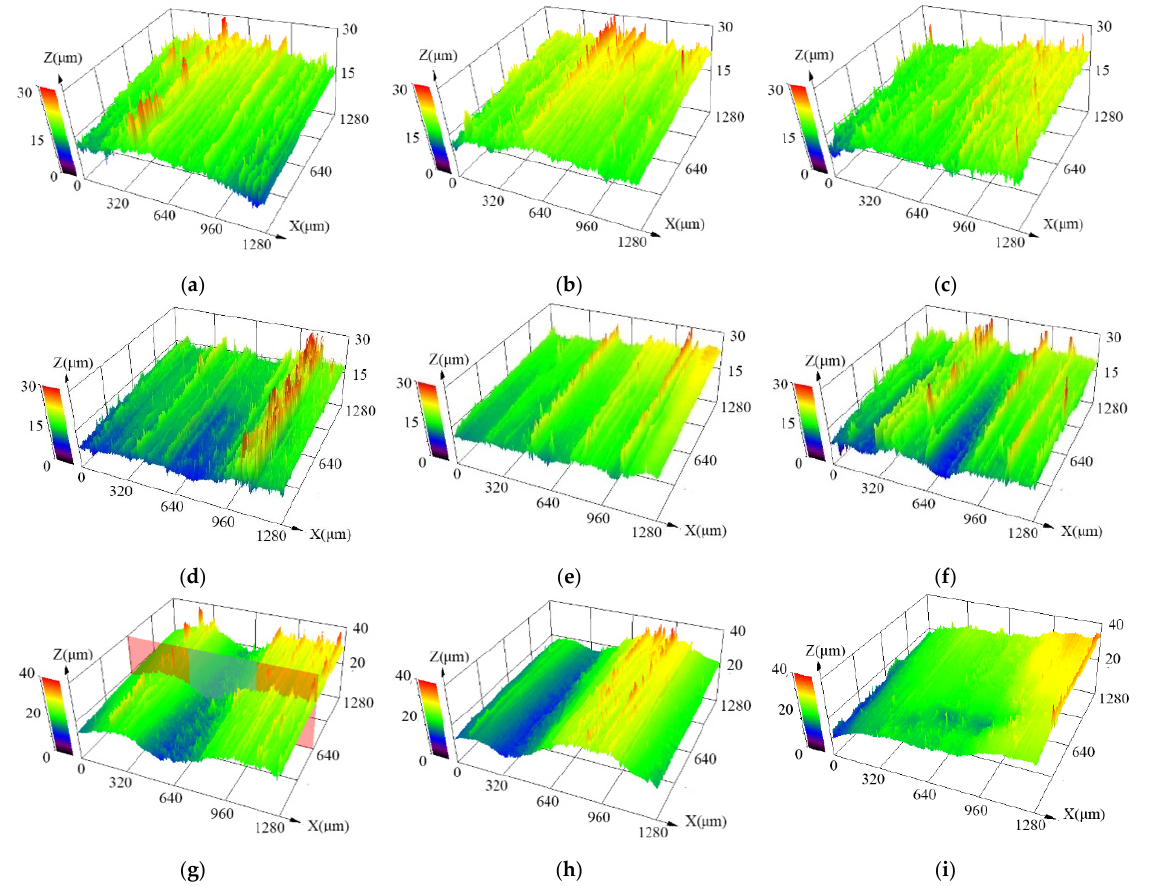
Figure 4. Three-dimensional surface morphology in the middle area of the AISI 4145H steel after being abraded by slurries with different softer abrasives: talc ( a – c ), dolomite ( d – f ) and fluorite ( g – i ). The slurries in ( a , d , g ) contains 5 wt.%, ( b , e , h ) 20 wt.%, and ( c , f , i ) 40 wt.% of abrasives. Table 6. Roughness of AISI 4145H steel after being abraded by slurry with dolomite. Abrasive Concentration (wt.%) Area Observed Ra ( µ